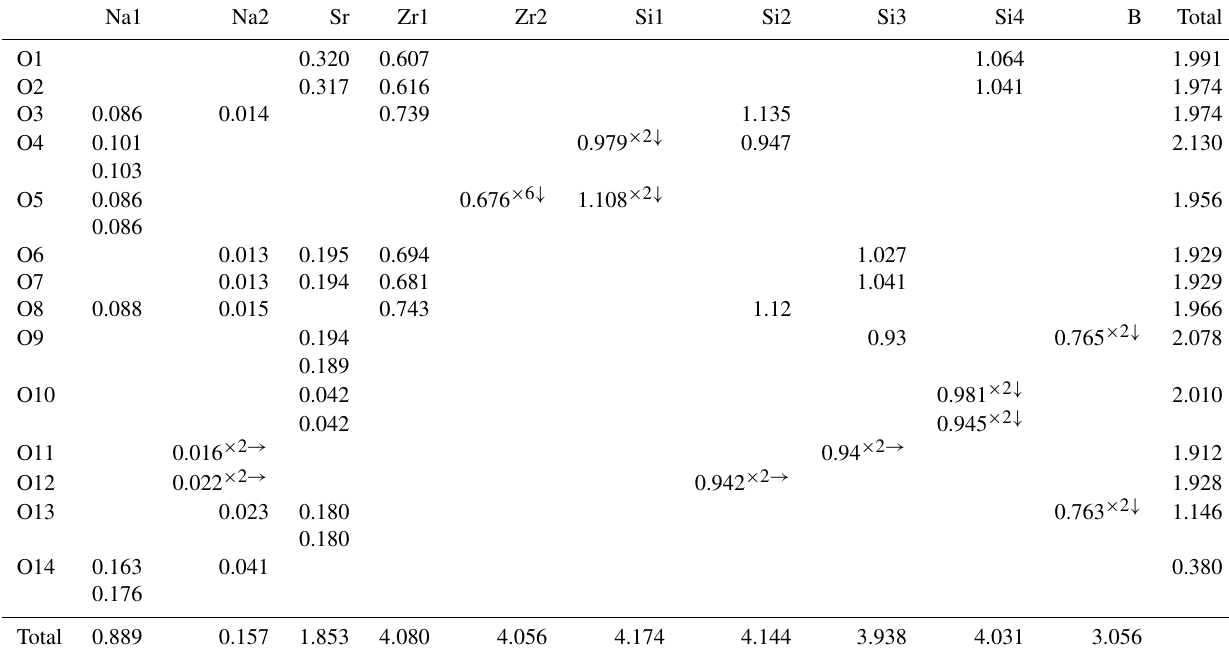
Table 6. Bond-valence calculation for bobtraillite.